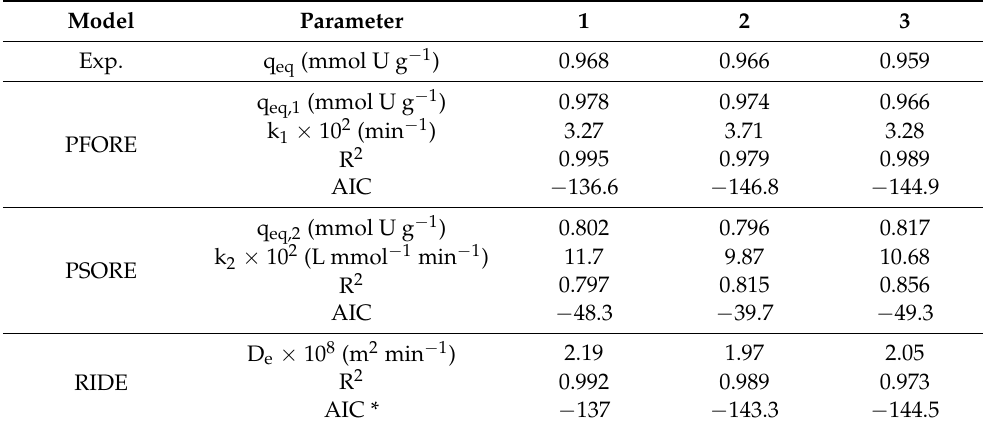
Table 4. The parameters of the three models for U(VI) uptake kinetics for the three experiments.